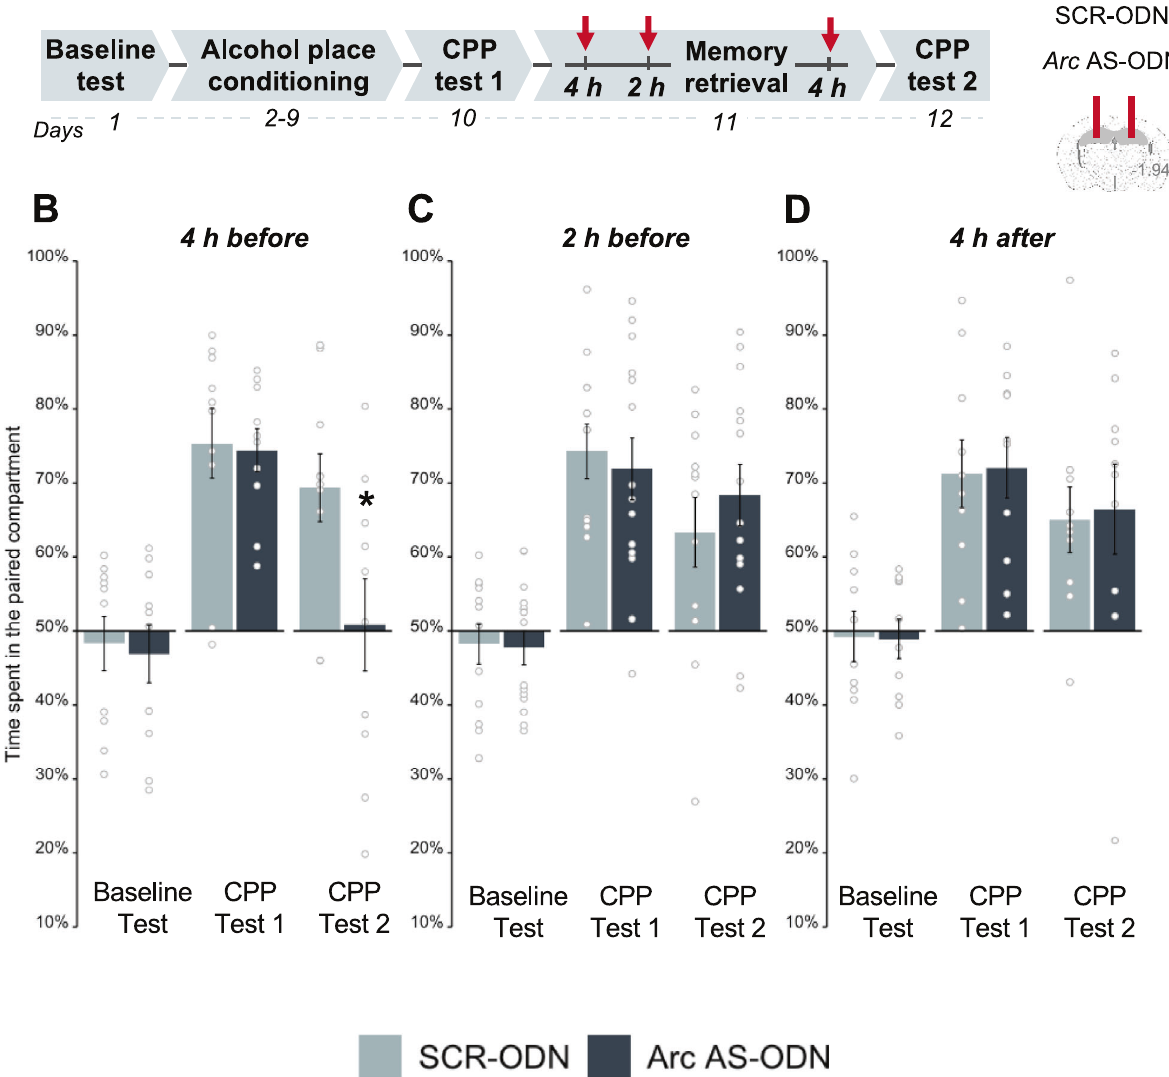
Fig. 3 Downregulation of ARC protein expression in the dorsal hippocampus shortly after alcohol memory retrieval disrupts the expression of alcohol-conditioned place preference (CPP). A . Schematic illustration of the experimental design and timeline. Antisense oligodeoxynucleotides directed against Arc mRNA ( Arc AS-ODN) or non-speci fi c scrambled oligodeoxynucleotides (SCR-ODN) were infused into the dorsal hippocampus (DH) of mice at the indicated time points. B – D Place preference scores, expressed as means ± S.E.M. of the percent of time spent in the alcohol-paired compartment. Infusion of Arc AS-ODN disrupted the expression of alcohol-CPP when infused 4 h (mixed-model ANOVA; Test (F (1,18) = 38.04, p < 0.001), and Test X Treatment (F (1,18) = 13.48, p < 0.01); post hoc: CPP test 2 ( p < 0.05)) ( B ) but not 2 h before memory retrieval (all p ’ s > 0.05) ( C ) or 4 h after memory retrieval (all p ’ s > 0.05) ( D ). * p < 0.05; n = 10 – 12 per (Figure S5, AS-ODN validation), alcohol memory was retrieved 4 h alcohol-CPP expression. To downregulate ARC levels in the DH after infusion, allowing the downregulation to occur an hour after during alcohol memory reconsolidation, we used antisense retrieval, at around the peak of increase in ARC protein levels oligodeoxynucleotides (AS-ODN) directed against Arc mRNA [56]. induced by alcohol memory retrieval (Figure S3C). When place Knockdown of ARC in brain regions related to memory preference was tested the next day, we found that alcohol-CPP consolidation and reconsolidation using Arc AS-ODN was pre- was abolished in mice that had received Arc AS-ODN, whereas SCR viously shown to disrupt the consolidation of aversive and ODN-treated mice still presented CPP (Fig. 3B). Our fi ndings thus appetitive memories [46, 47, 56, 57] and the reconsolidation of suggest that intra-hippocampal infusion of Arc AS-ODN disrupted fear memories [46, 47, 57], as well as to impair morphine- the reconsolidation of alcohol memories by preventing the associated memory reconsolidation [22]. increases of ARC protein levels caused by memory retrieval. To test whether ARC downregulation disrupts alcohol memory To further test whether this memory disruption was due to reconsolidation and abolishes alcohol seeking, we trained mice to blockade of the post-retrieval ARC induction speci fi cally, we chose show alcohol-CPP (Fig. 3B, see Figure S4 for individuals ’ data). A a second time point within the theoretical 5 – 6 h [9, 10] day after CPP test 1, the mice received an intra-hippocampal “ reconsolidation window ” for Arc AS-ODN infusion. Given that infusion of Arc AS-ODN or control scrambled (SCR)-ODN. Since the the increase in the expression of ARC protein peaked 1 h after AS-ODN downregulated ARC protein levels 5 h after infusion [57]